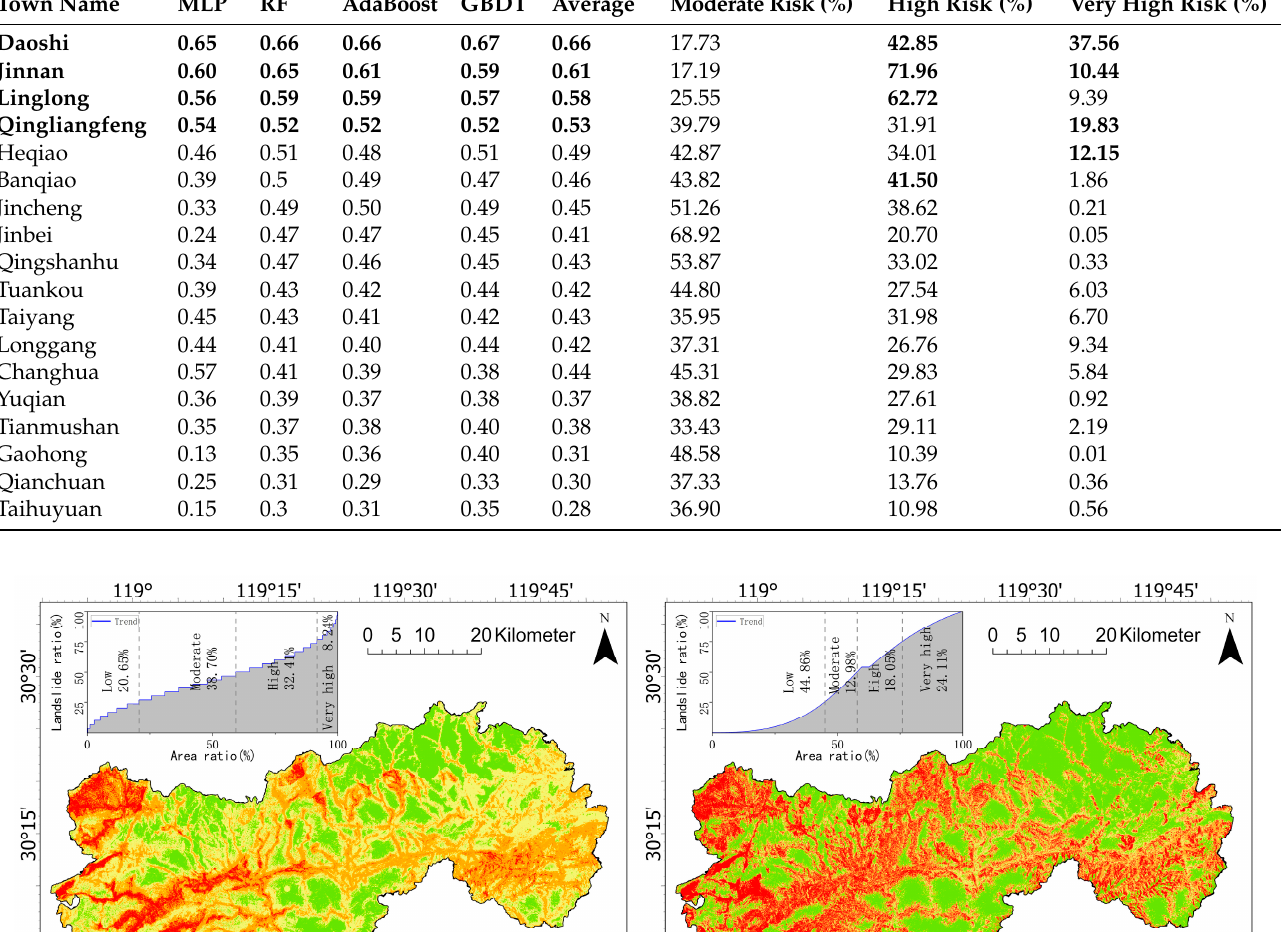
Table 7. Town-level mean landslide susceptibility and leading top three contributors based on the four models. Note: the bold numbers indicate the top “high prone” risk.